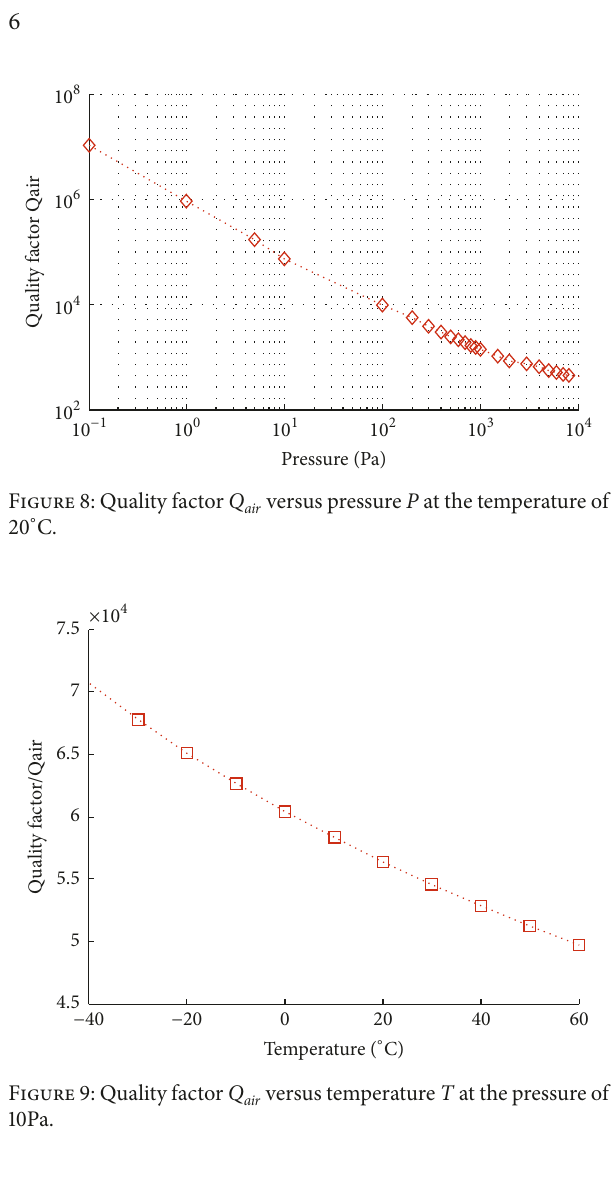
Table 2: QUALITY FACTOR OF DAMPING DISSIPATION.